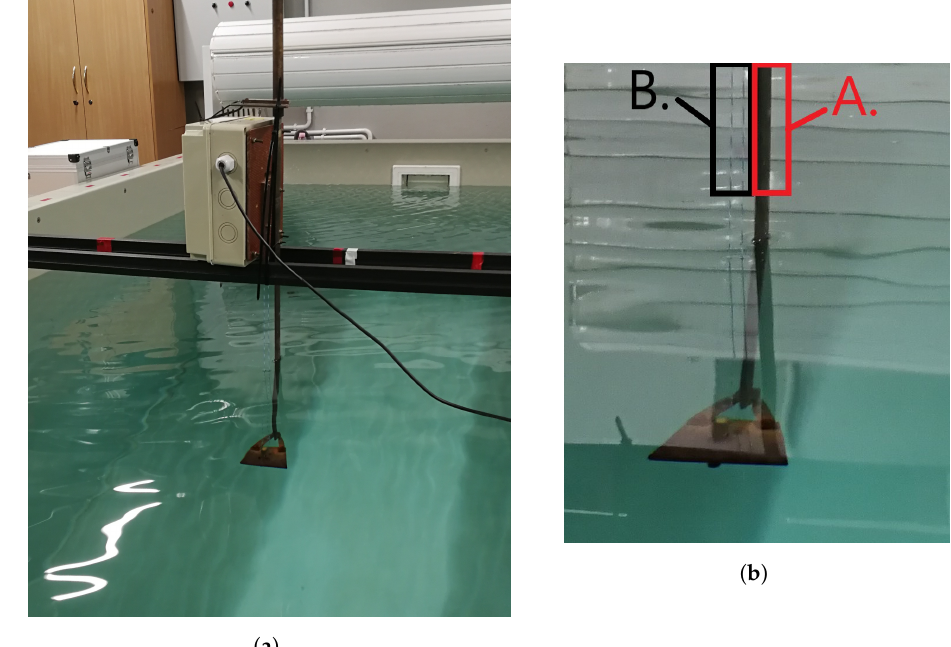
Figure 1. Experiment of wavemeter scaling in a pool: ( a ) wavemeter and ( b ) zoomed-in wavemeter part with two electrodes (A and B)